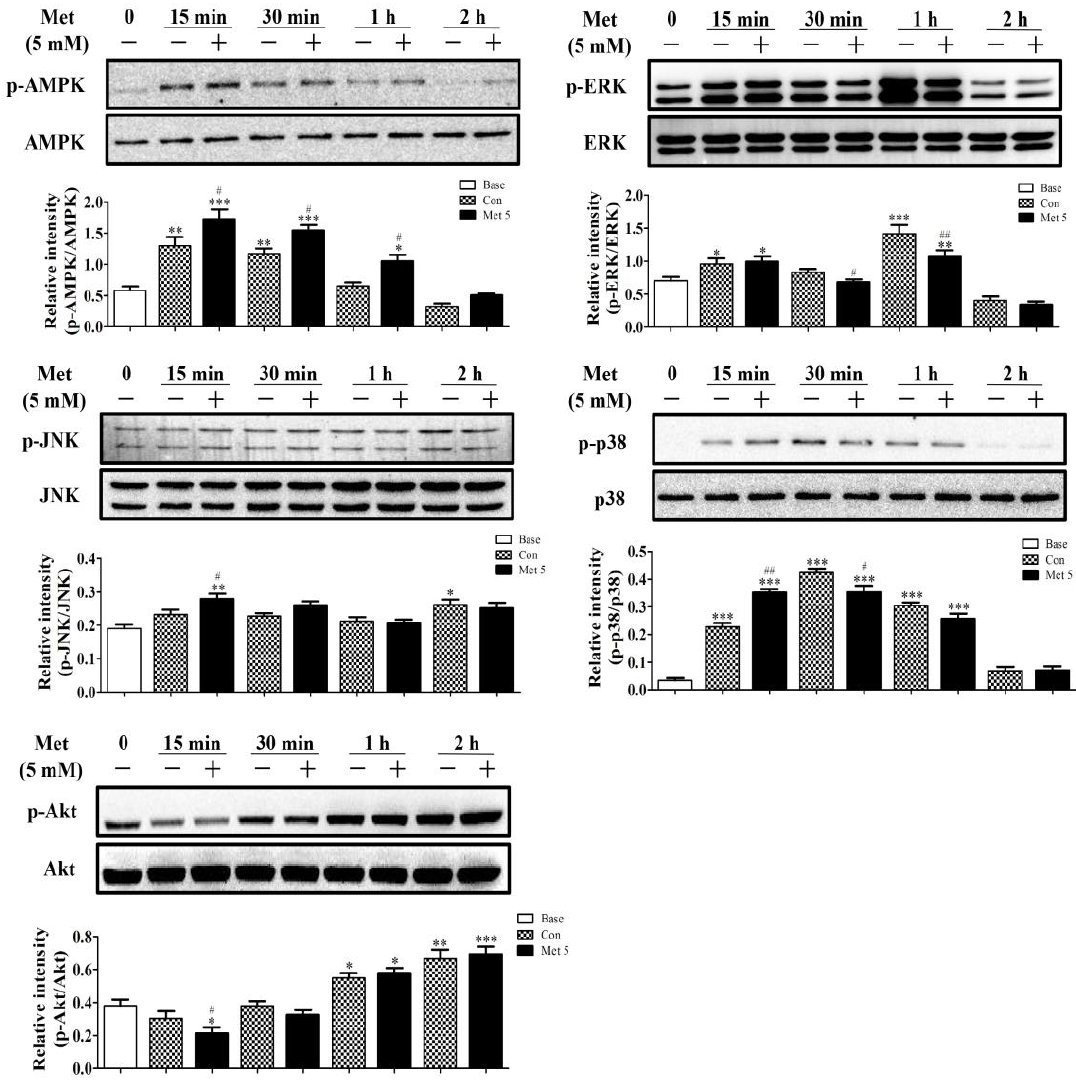
Figure 5. Time course of 5 mM of metformin on phosphorylation of MAPKs, Akt and AMPK in 3T3-L1 cells. Cells were cultured in DMI containing 5 mM of metformin for indicated time points; cell lysates were then collected and the expressions were determined by Western blot. Results were quantified using densitometry and normalized to total MAPKs, Akt, or AMPK accordingly ( n = 3). “0” represents untreated cells (without DMI). Data represent the means ± SEM from three experiments. * p < 0.05, ** p < 0.01, and *** p < 0.001 as compared with untreated cells (time ”0”); # p < 0.05 and ## p < 0.01 as compared with DMI alone treated cells at each time point (one-way ANOVA with post hoc Bonferroni’s correction ).